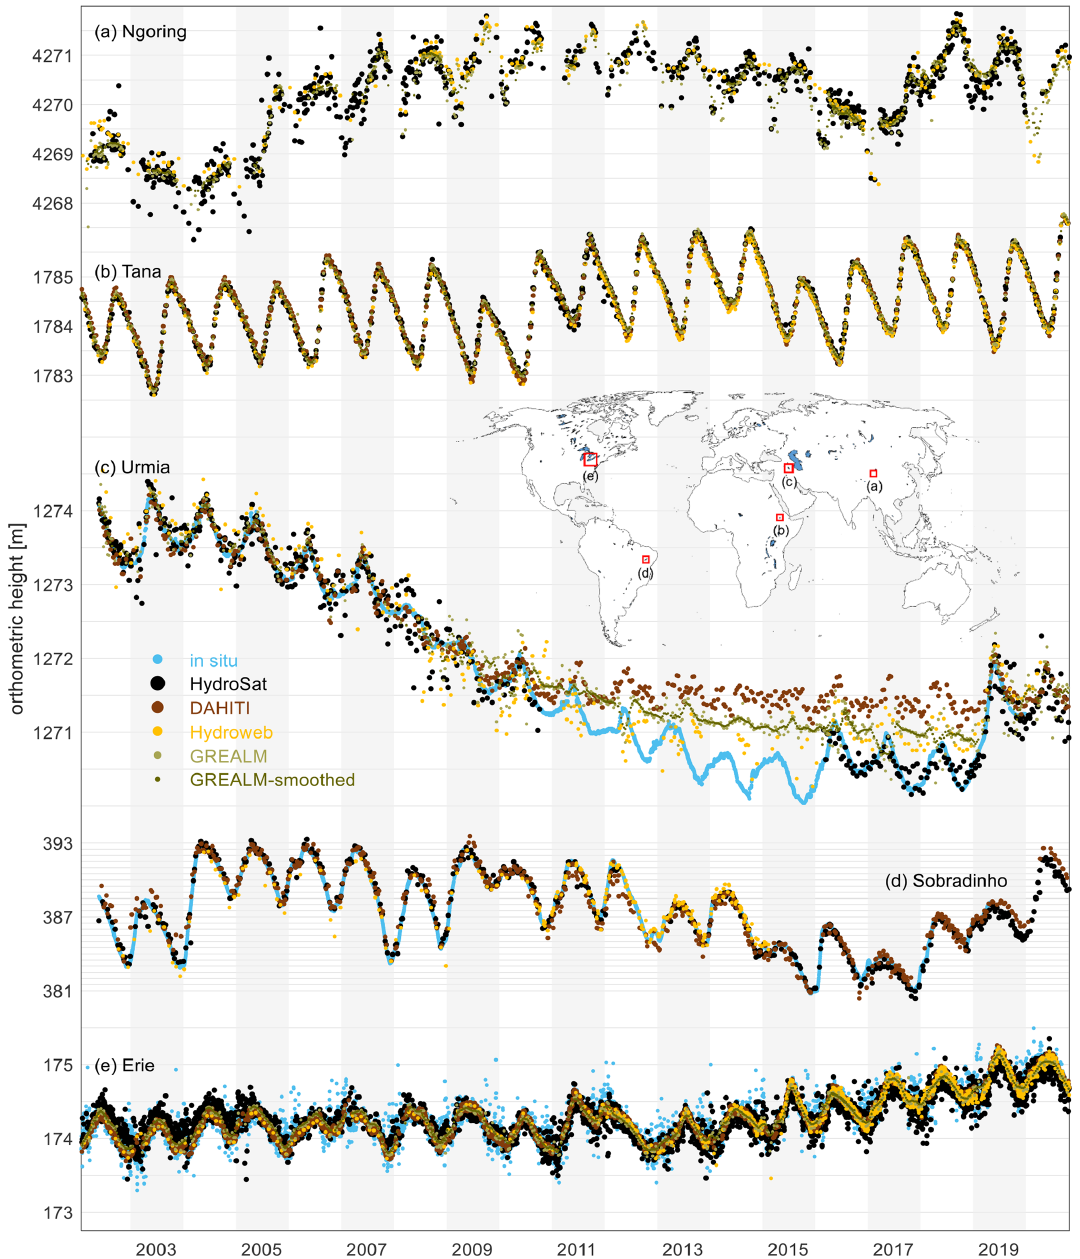
Figure 2. High-rate altimetric water level time series over lakes Ngoring in China (610km 2 ) from Envisat, SARAL/AltiKa, Jason-1, Jason-2, Jason-3 and Sentinel-3A; Tana in Ethiopia (2156km 2 ) from Envisat, SARAL/AltiKa, Jason-1, Jason-2, Jason-3, Sentinel-3A and Sentinel- 3B; Urmia in Iran (5200km 2 ) from Envisat, Jason-1, Sentinel-3A and Sentinel-3B; Sobradinho in Brazil (4214km 2 ) from Envisat, SAR- AL/AltiKa, Sentinel-3A and Sentinel-3B; and Erie in North America (25744km 2 ) from Envisat, SARAL/AltiKa, Jason-1, Jason-2, Jason-3, Sentinel-3A and